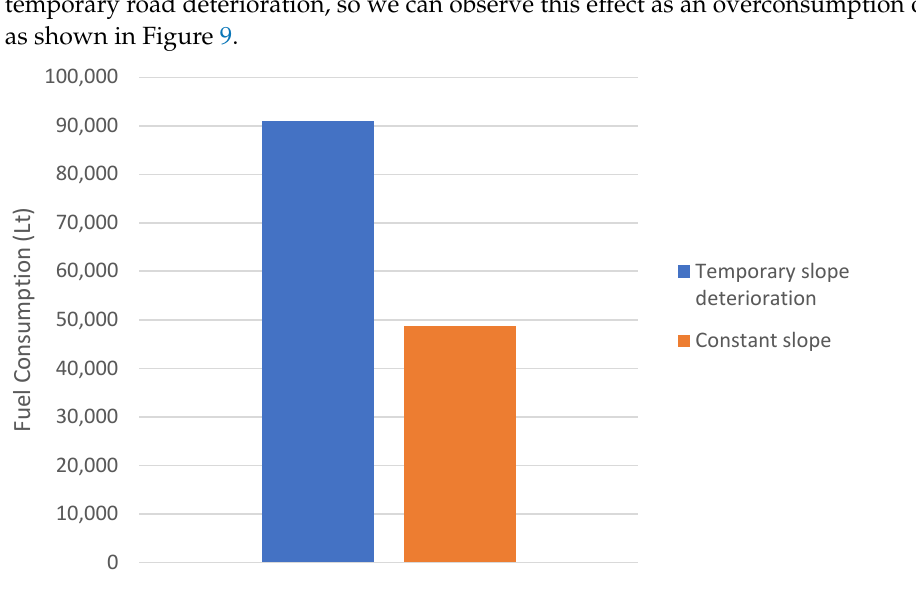
Figure 9. Comparison of fuel consumption level between a simulation model that does not consider road wear (constant RR) and a model that does (variable RR).